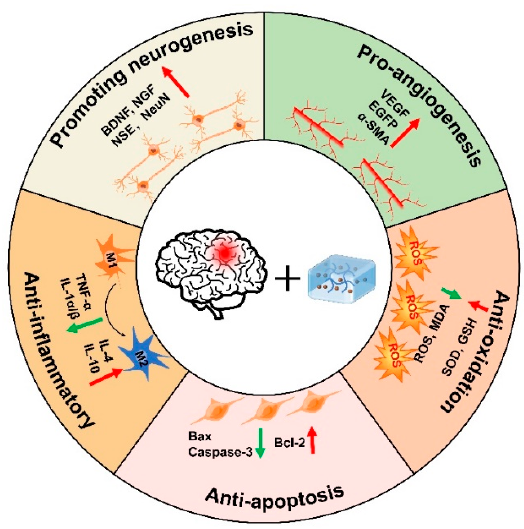
Figure 5. Therapeutic mechanisms of injectable hydrogels in TBI. Table 1. Therapeutic mechanisms of injectable hydrogels in